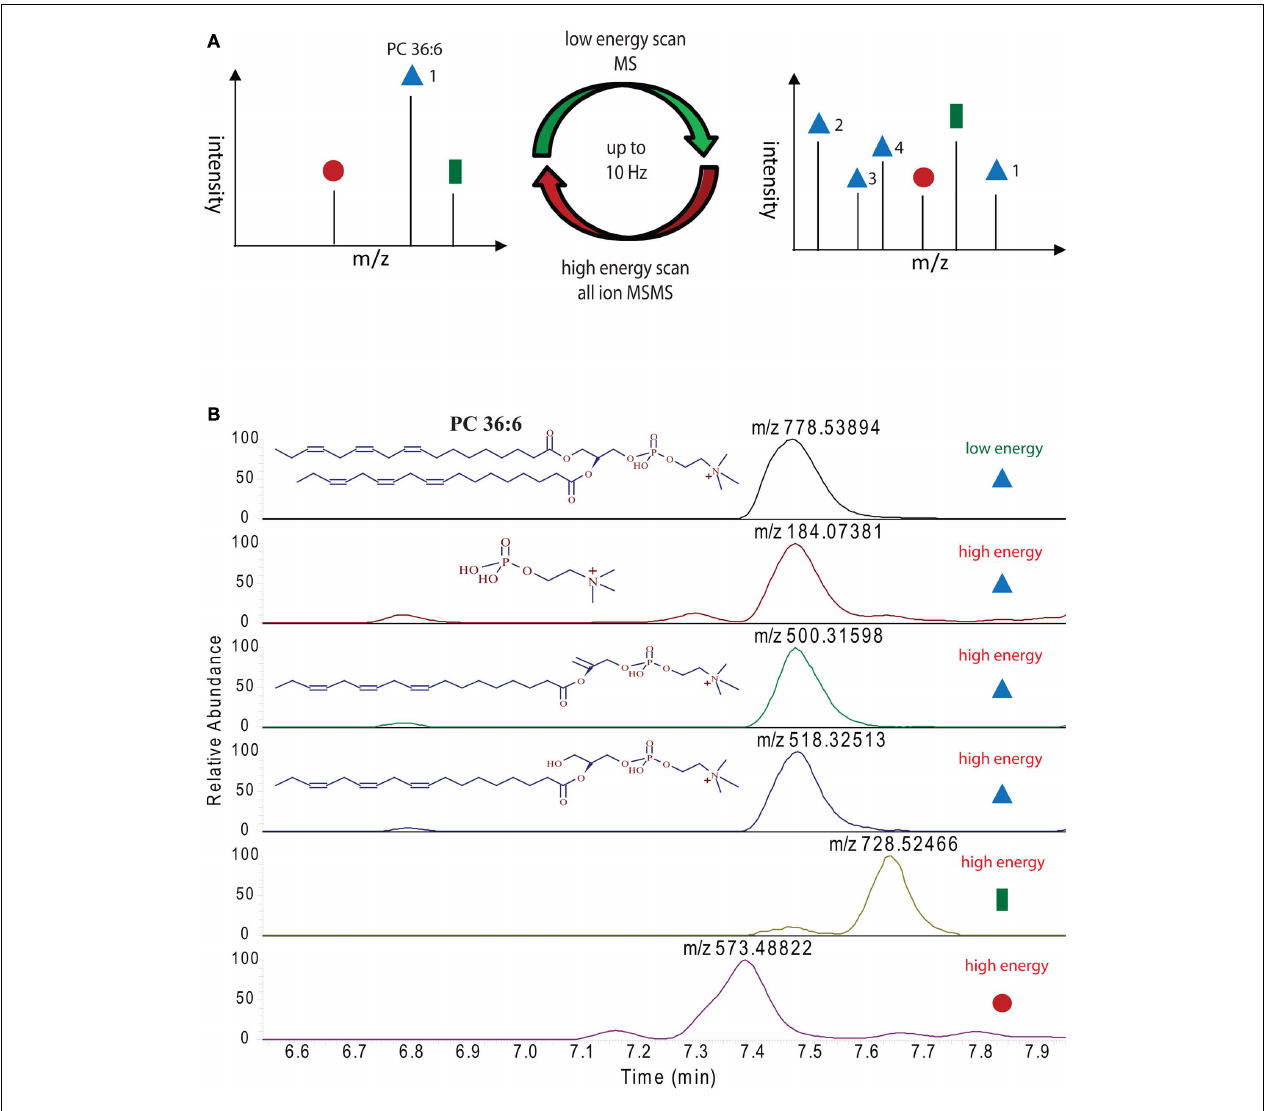
energy mass spectra) from a representative positive ion modes UPLC chromatogram. Peaks with the same elution profile can be regarded as co-eluting masses, which are derived from the same precursor molecule. Differentially eluting peaks have to be regarded as different compounds, requiring different